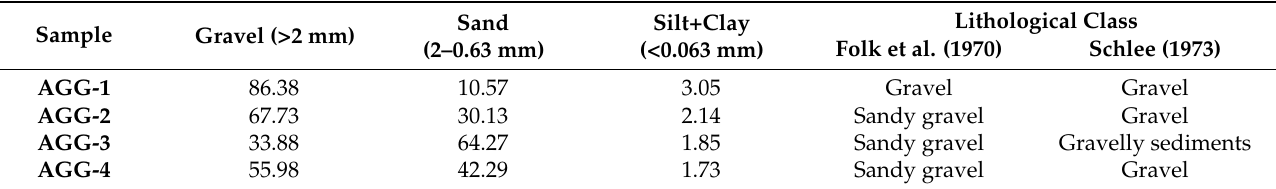
Table 1. Grain size (wt.%) and classification of the studied samples.